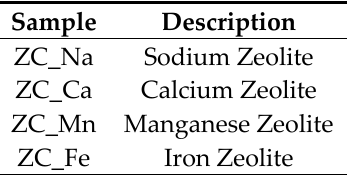
Table 1. Adsorbent